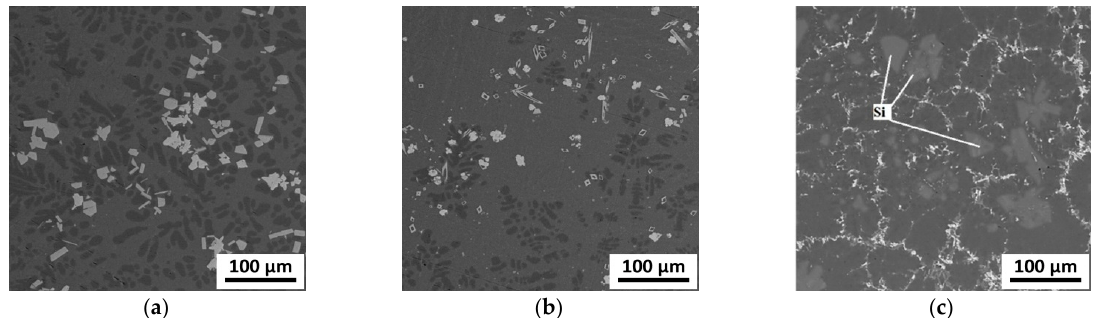
Figure 4. SEM images showing the microstructure of the experimental as-cast alloys showing a natural composite structure and FM180 alloy: ( а ) Al-6Ca-3Mn; ( b ) Al-8Ca-2Mn; ( c ) FM180. Table 2. Calculated phase transformation temperatures, hardness and electrical conductivity of the as-cast Al-Ca-Mn alloys.